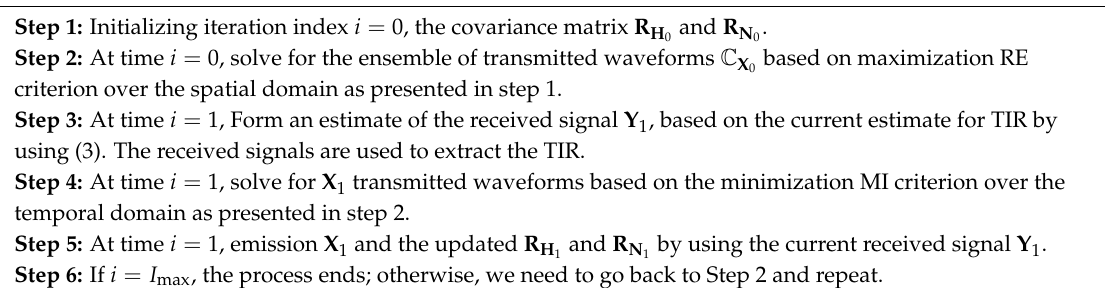
Algorithm 1. The information embedding MIMO waveform optimization algorithm